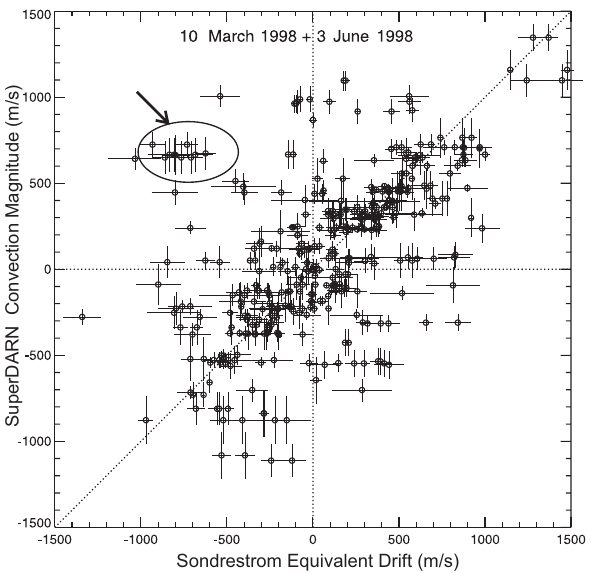
Fig. 6. Comparison of the HF radar convection magnitude and the ISR l-o-s velocities projected on the SuperDARN radar vectors.